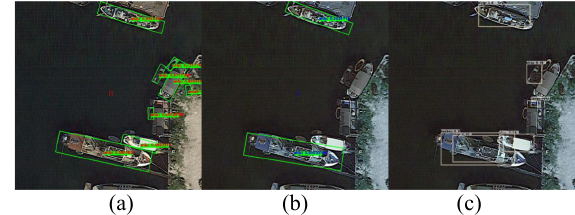
Fig.6 Traditional NMS vs. Rotated